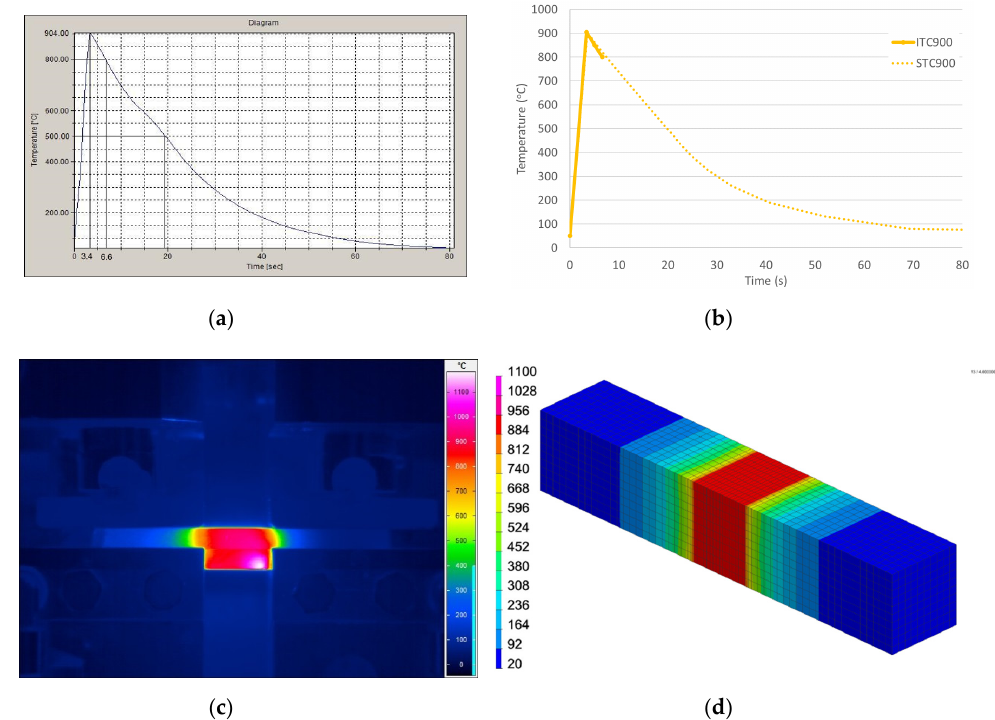
Figure 7. Comparison of ( a ) the registered and ( b ) the calculated thermal cycle as well as ( c ) the thermographic image and ( d ) the result of the numerical analysis in the form of temperature distribution for the thermal cycle with T max = 900 °C.